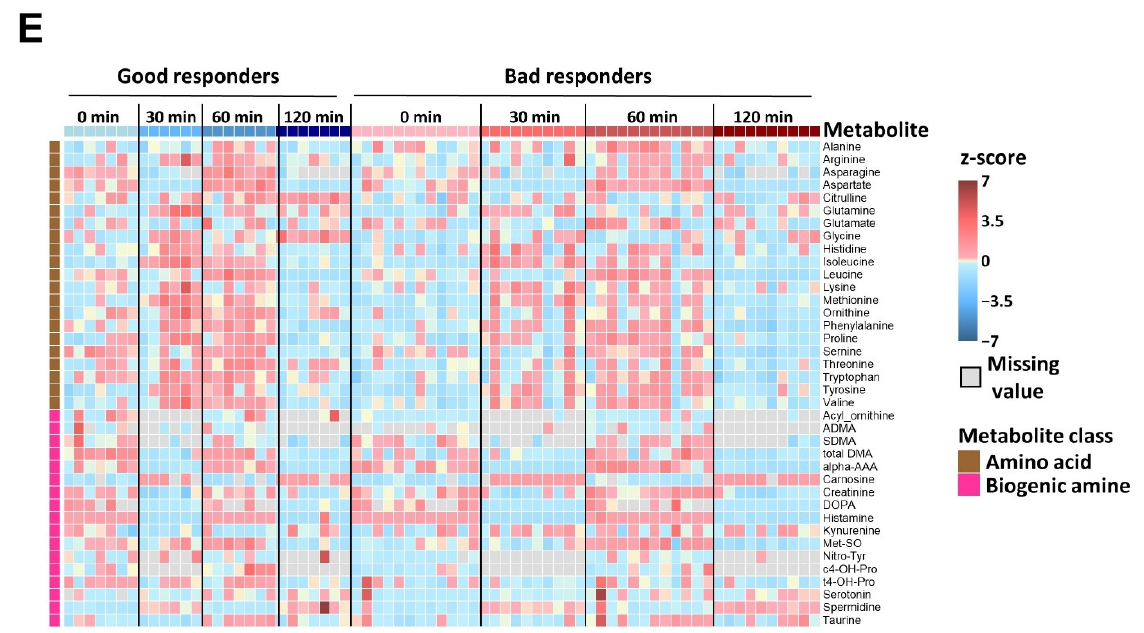
Figure 3. Circulating metabolites at fasted state and in response to a standardized meal test in patients with extreme weight loss response to RYGB. Three short chain fatty acids were quantifiable (propionate, valerate and acetate). Concentration of propionate ( A ) and valerate ( B ) are illustrated before (0 min) and 30, 60 and 120 min after ingestion of the liquid test meal with significance values calculated by Kruskal–Wallis test with pairwise post-hoc Dunn’s test. Values with different letters (a, b, c) are significant to each other. Beta-diversity based on principal component analysis of amino acid and biogenic amine pool in good and bad responders ( C , D ) after RYGB. Significance calculated by PERMANOVA. ( E ) depicts relative abundance (z-scores) of amino acids and biogenic amines measured before (0 min) and 30, 60 and 120 min after ingestion of the liquid test meal.